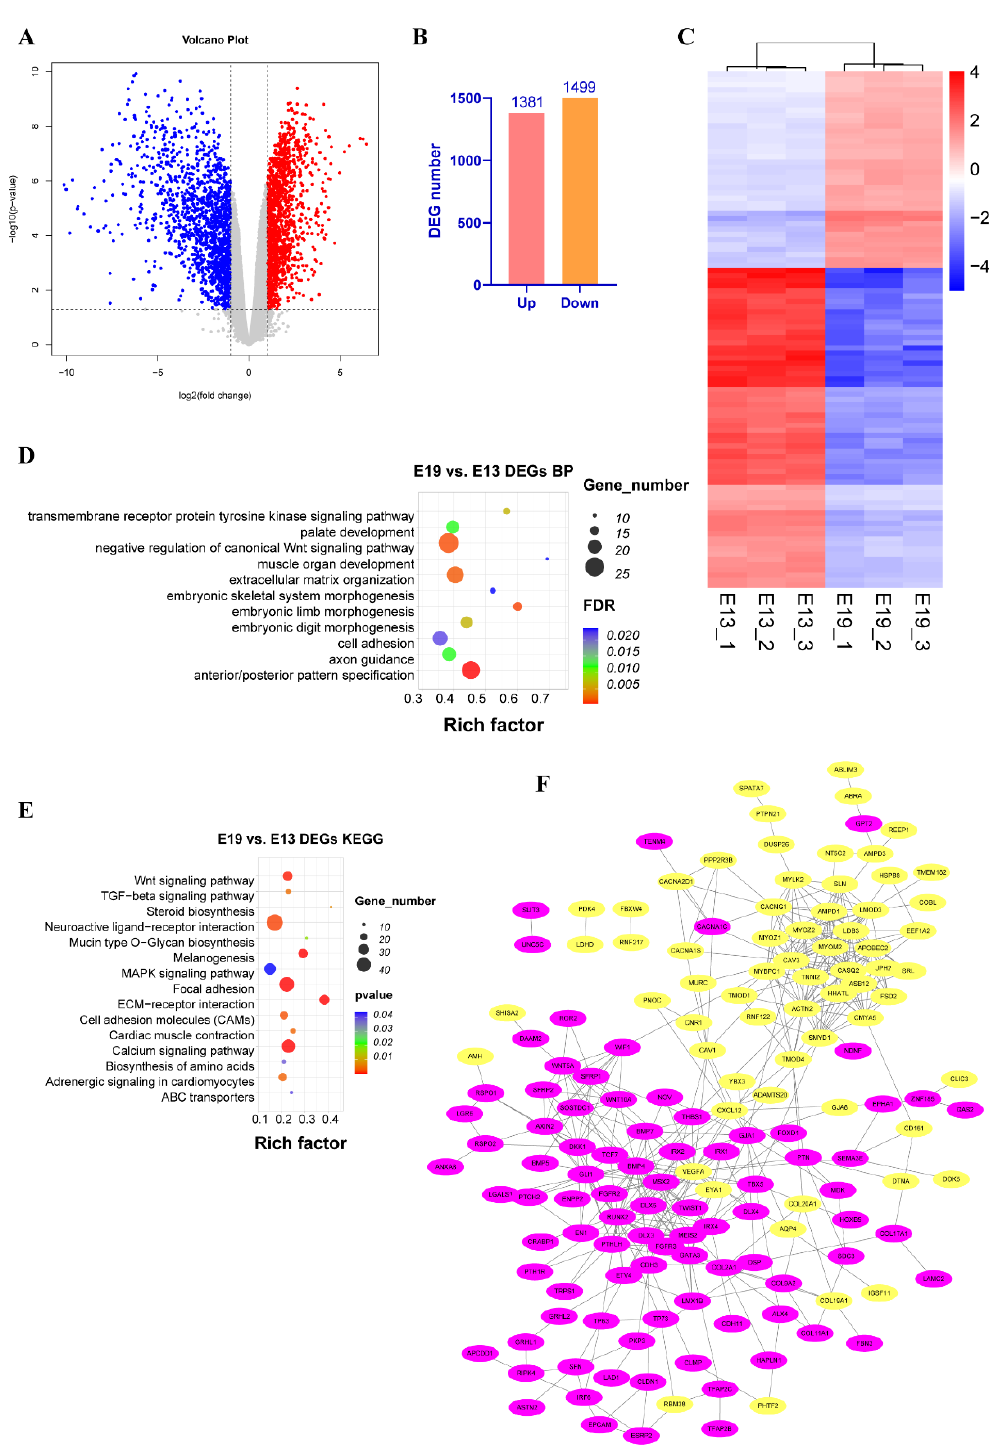
nodes stand for the hyper-methylated peak genes; the pink nodes indicate the hypo-methylated peak genes.